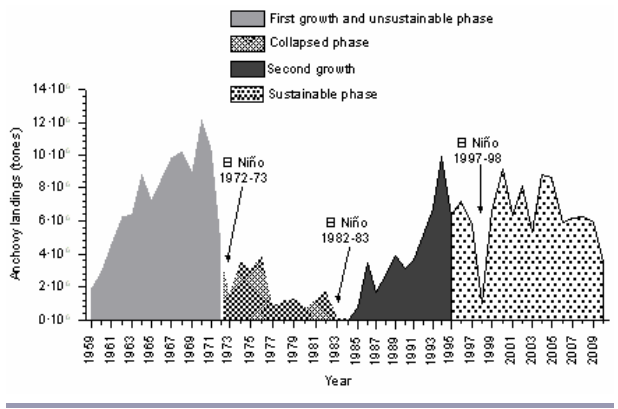
Fig. 1 . Historical Peruvian anchovy landing, major El Niño events, and phases of the